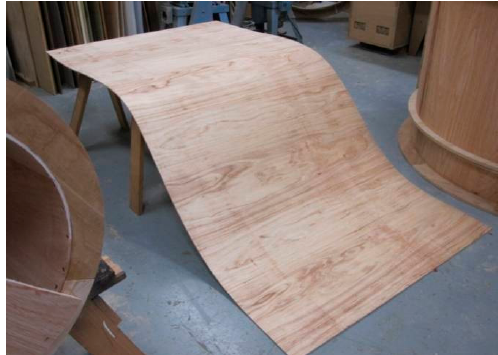
Figure 2. A sheet of 6 mm bendy ply.